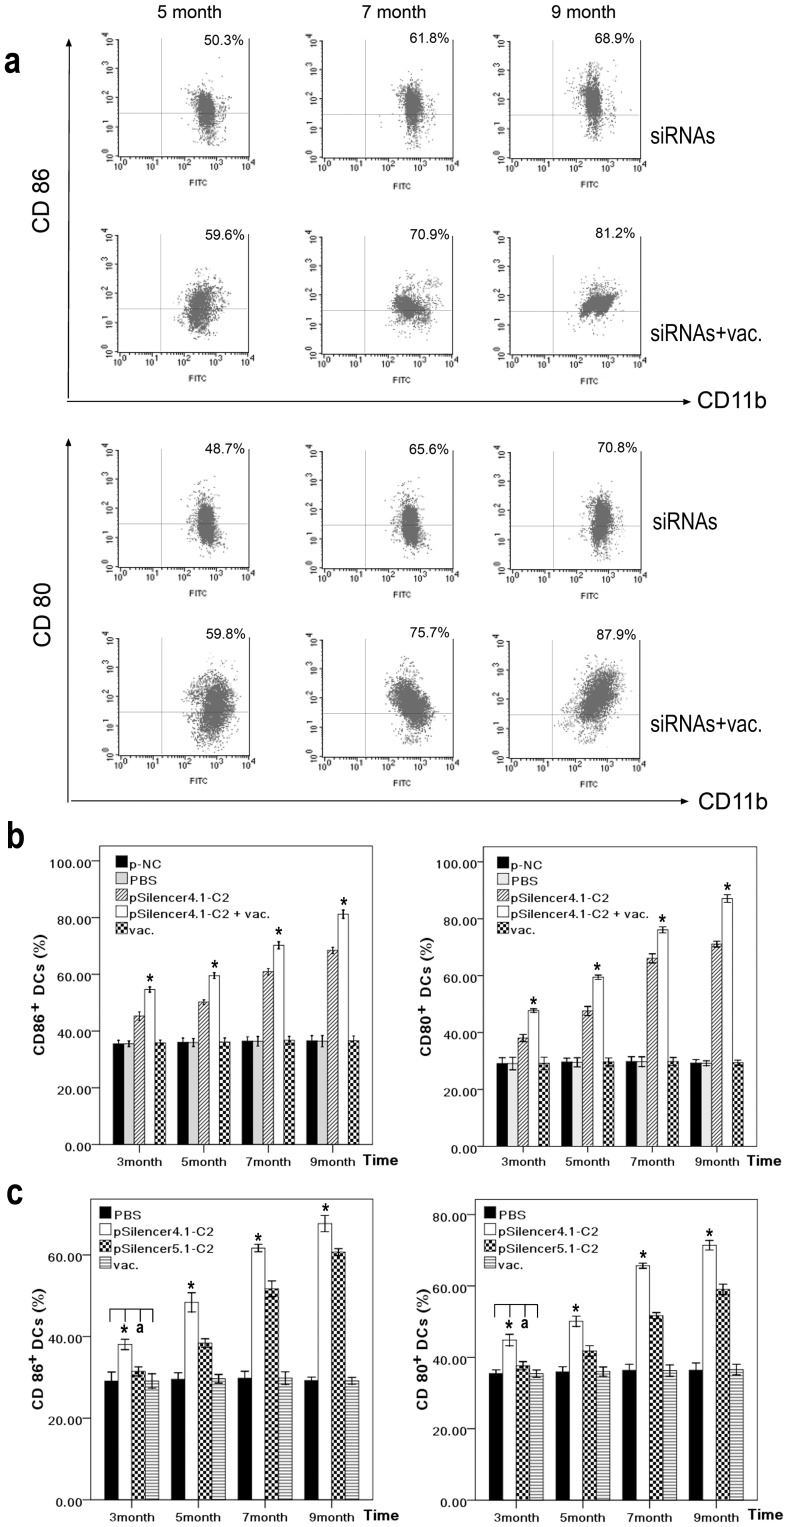
Accommodation effect of the HBV vaccine on the innate immune system in siRNA-treated HBV transgenic mice.The isolated and cultured dendritic cells (DCs) were stained with CD11b, CD86 and CD80 specific abs. CD11b gated liver DCs were examined for CD86 and CD80 expression respectively at different time points in siRNAs (pSilencer 4.1-C2) and siRNAs with vaccination group by flow cytometry (a). And cultured DCs were sorted to identify the changes of CD80 and CD86 on the sixth day (b). The transgenic mice vaccinated single group, negative-control plasmid (p-NC) and PBS injected mice are set as controls. Moreover, the changes in the CD80+ and CD86+ DCs between pSilencer 4.1-C2 and pSilencer 5.1-C2 treated groups were counted to evaluate the different effects of the two vector-driven siRNAs on the innate immune system (c). Results are representative of at least four separate experiments. Error bars represent the standard error (SE) of mean. (*: p<0.05, a: p>0.05).